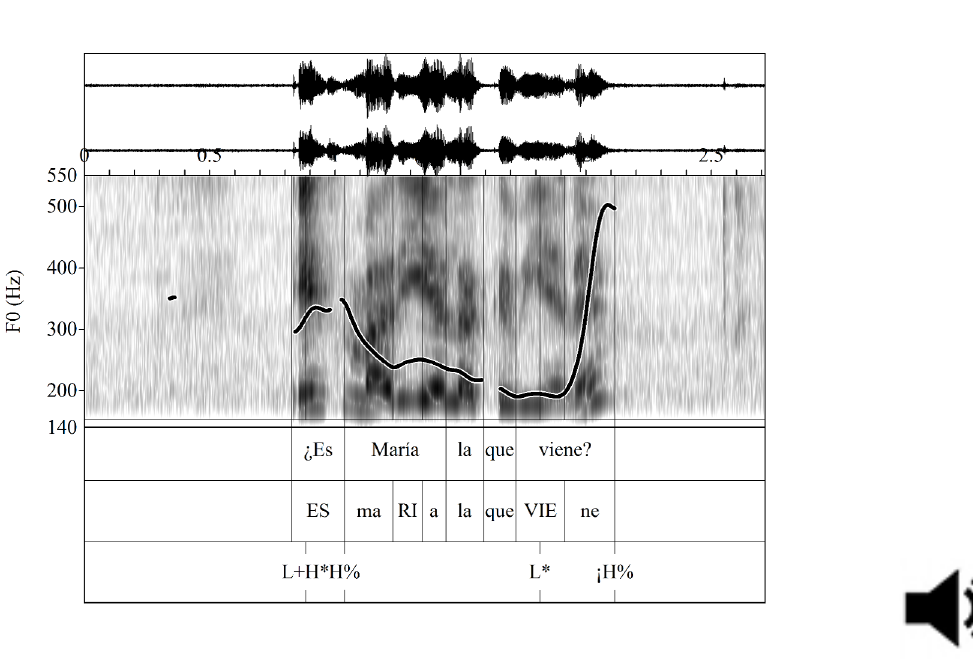
Figure 12 (Participant 10): Waveform and F0 trace for the emphatic yes-no question ¿ Es María la que viene? ‘Is María the one who’s coming?’ produced as two IPs: L+H* H% (1 st IP nuclear configuration) and L* ¡H% (2 nd IP nuclear configuration).